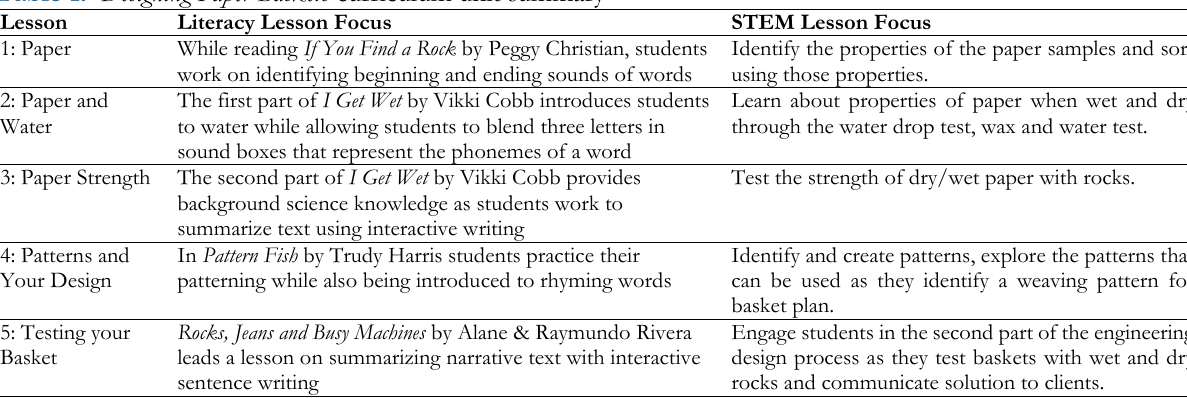
Table 1. Designing Paper Baskets curriculum unit